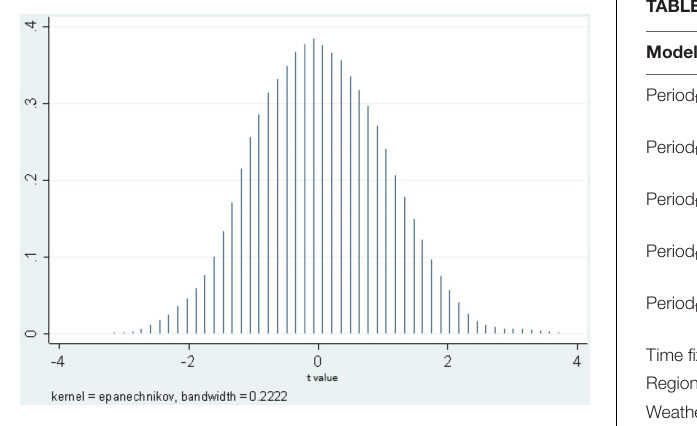
FIGURE 6 | Kernel density estimation of placebo test.